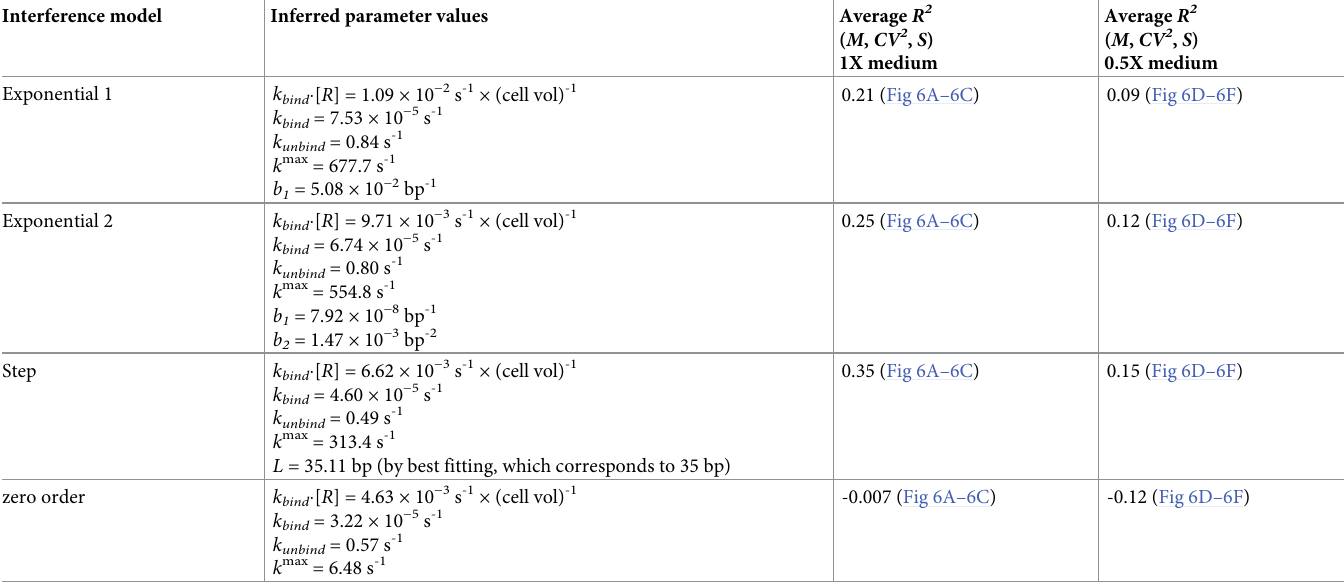
Table 3. Parameter values inferred for each